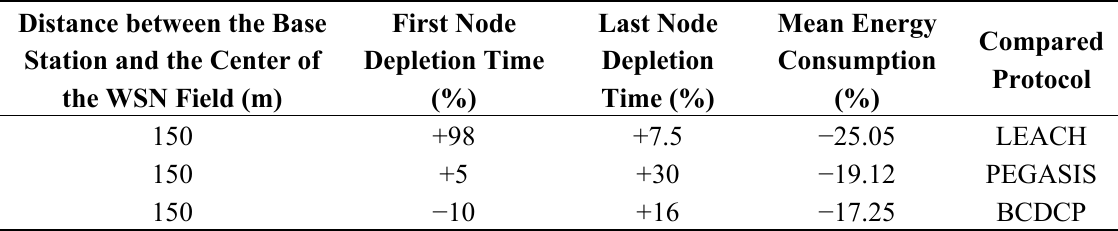
Table 1. Comparison of ECHERP to LEACH, PEGASIS and BCDCP as a function of the distance of the base station from the center of the sensor field when the initial node energy is set to 2 J.